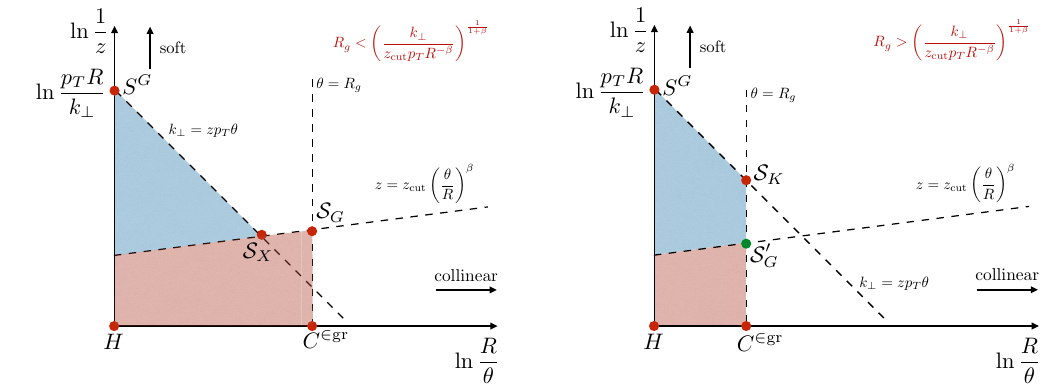
Figure 3 . Lund diagrams for the angle between the standard and the groomed jet axis when k z cut p T R , for regime A (left) and B (right). The relevant SCET modes are indicated by red ? (cid:28) and green dots, and their power counting can be read o(cid:11), see table